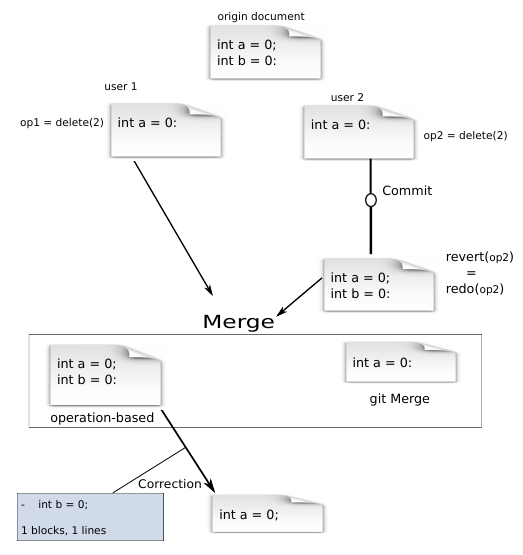
Figure 14. undo/redo